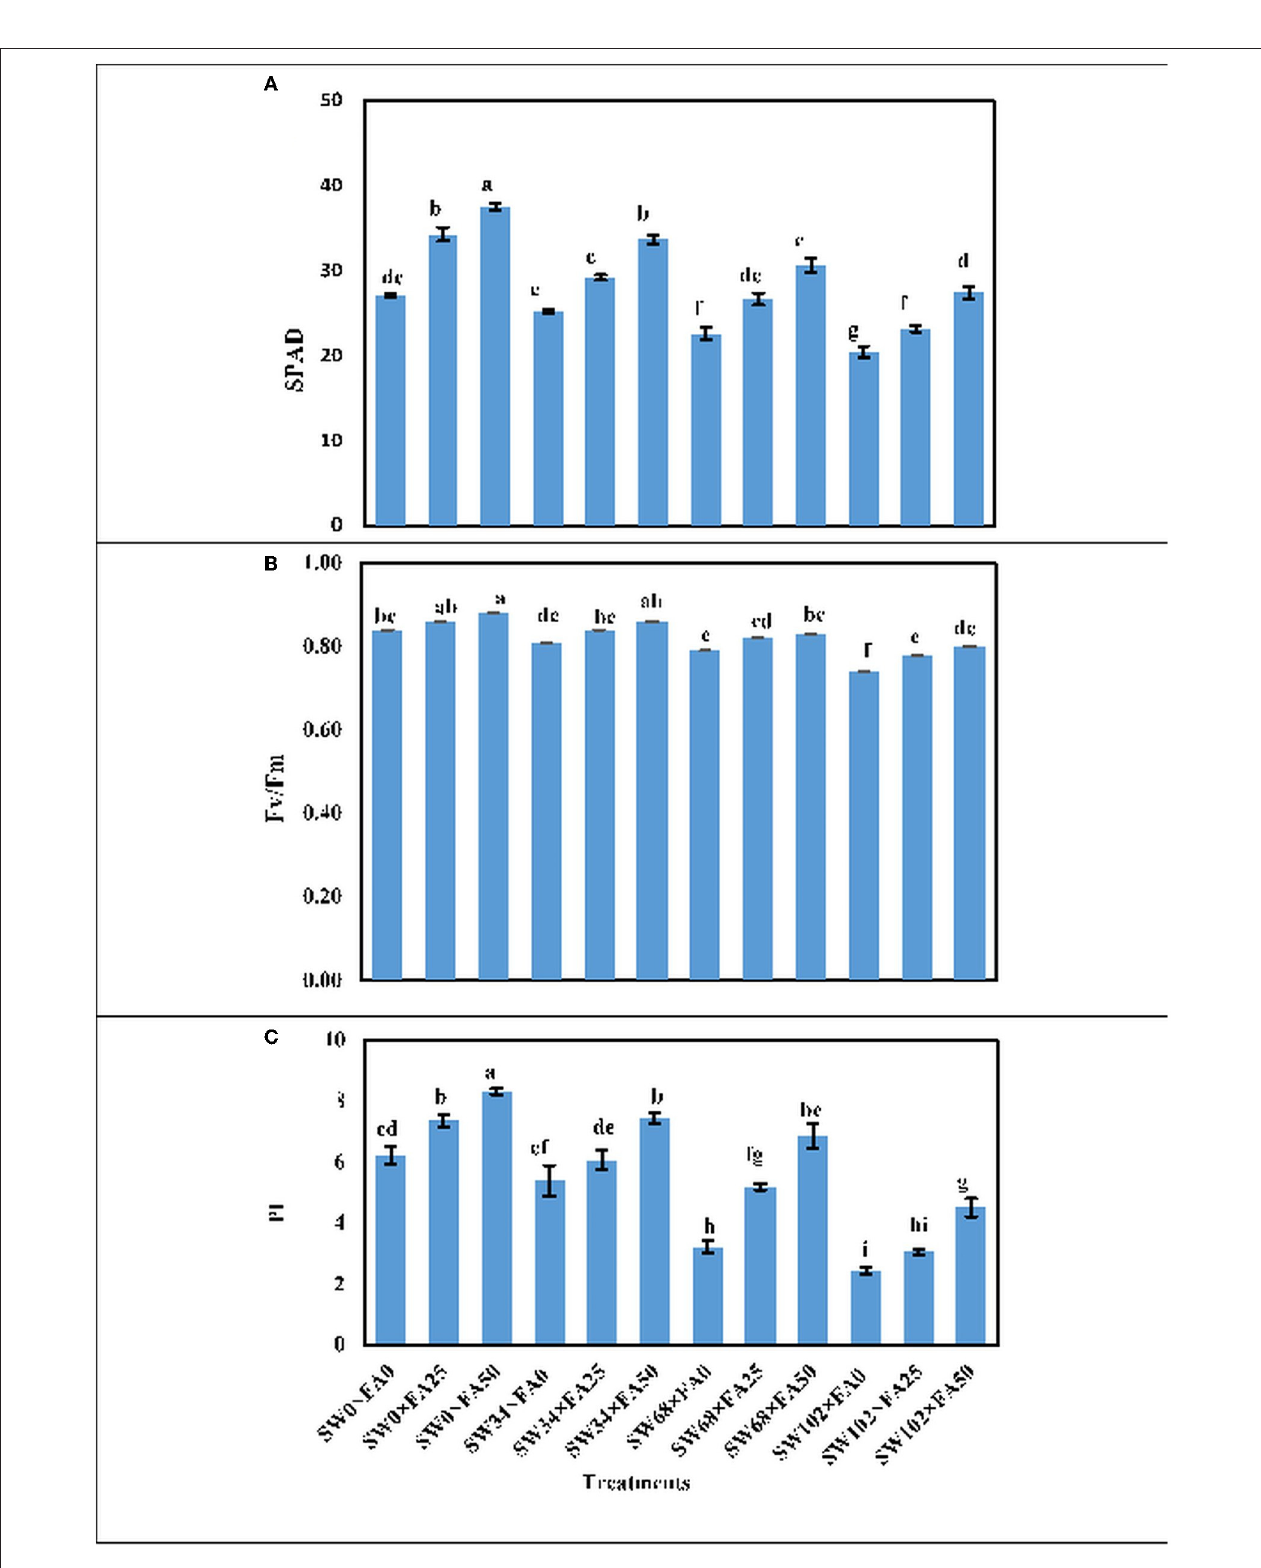
FIGURE 1 | The interactive effect of folic acid (FA) and saline water (SW) on photosynthetic productivity of Plectranthus amboinicus . (A) SPAD; (B) Fv/Fm; and (C) PI of P. amboinicus measured in the two seasons of 2018/2019 and 2019/2020. Different letters on the bars refers to significant differences among means based on Fisher’s least-significant difference test at p < 0.05. SPAD, total chlorophyll (soil plant analysis development); Fv/Fm , chlorophyll fluorescence; PI , performance index; SW0, 0mM NaCl; SW34, 34mM NaCl; SW68, 68mM NaCl; SW102, 102mM NaCl; FA0, 0 µ M FA; FA 25, 25 µ M FA; FA50, 50 µ M FA.